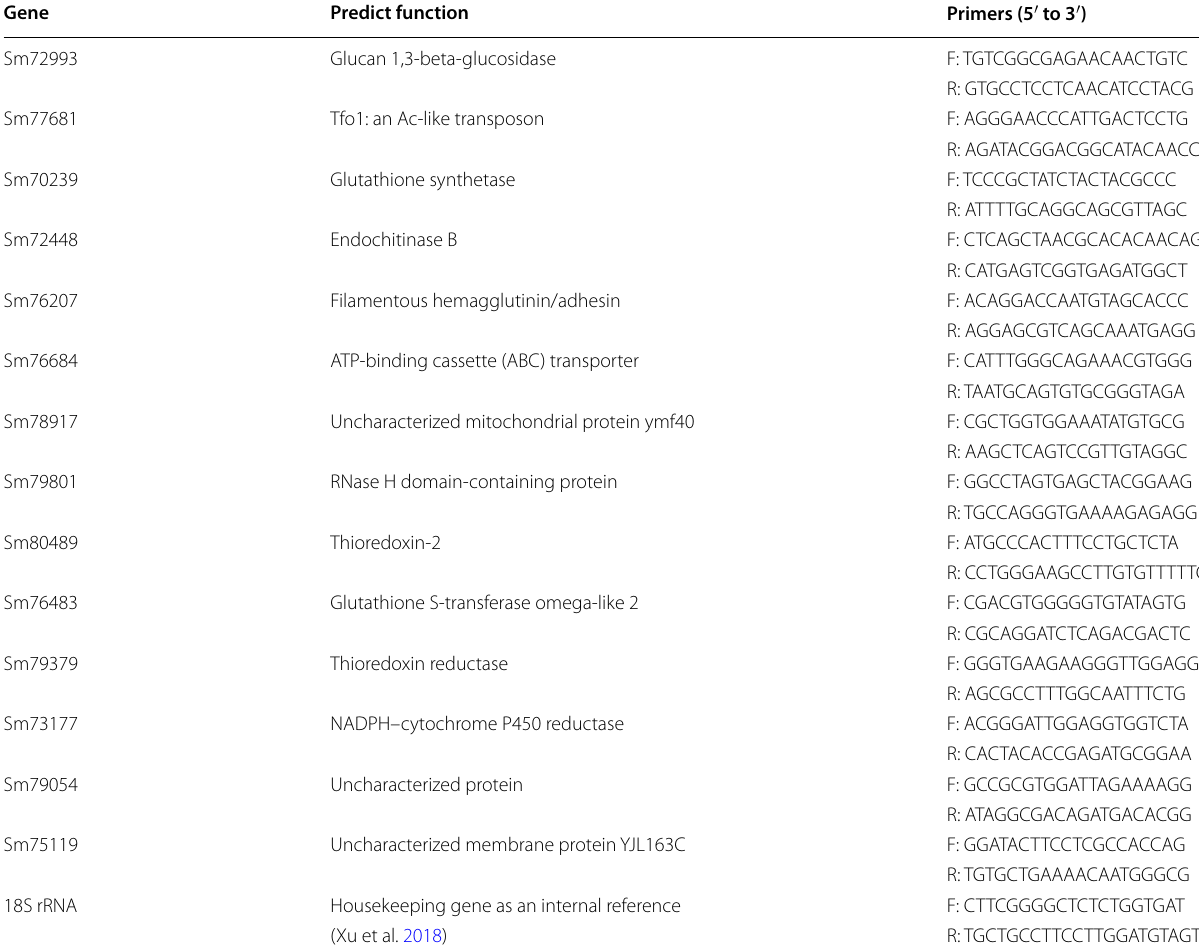
Table 1 Primers used in this study Gene Predict